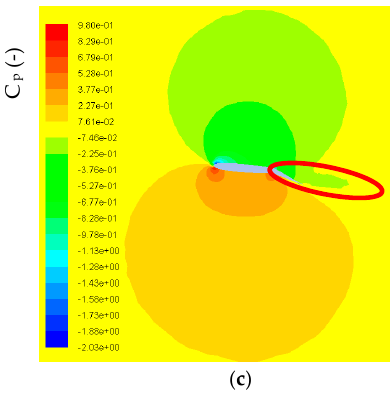
Figure 25. Images showing pressure cut plots at the location where vortices are generated on each wings flap at 5 degrees’ angle of attack ( a ) the conventional wing; ( b ) Initial morphing wing; ( c ) optimized morphing wing.